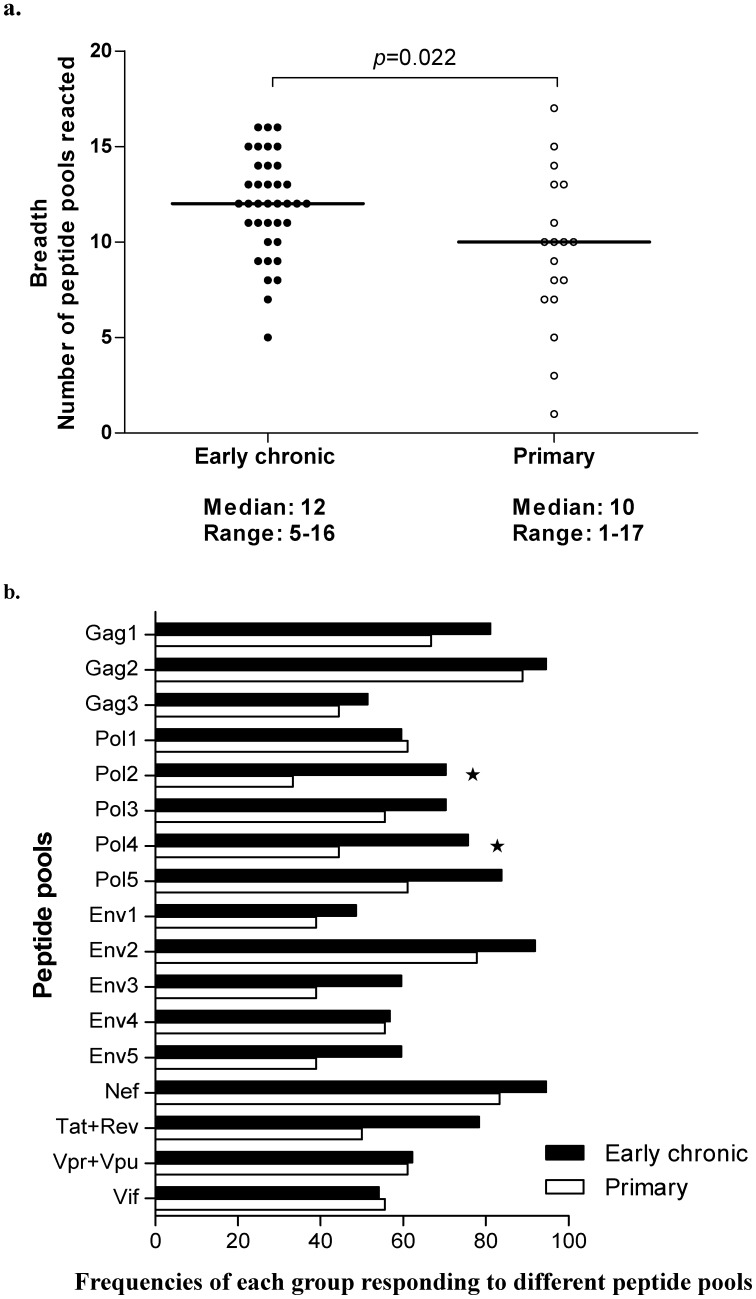
Comparison of the breadth, frequency and magnitude of responses (measured by IFN-γ Elispot and given as SFC/106 PBMCs) between primary and early chronic phase of HIV infection.a. Summary of the number of peptide pools responded (breadth) per individual in primary and early chronic HIV-infected individuals. b. Frequencies of each patient group responding to different peptide pools. The percentages of each patient group mounted a positive response in an Elispot assay to each particular peptide pool were quantified, e.g. greater than 90% of all early chronic subjects mounted a positive response to the Nef pool. Statistically significant differences between groups (p<0.05) were denoted by an asterisk.